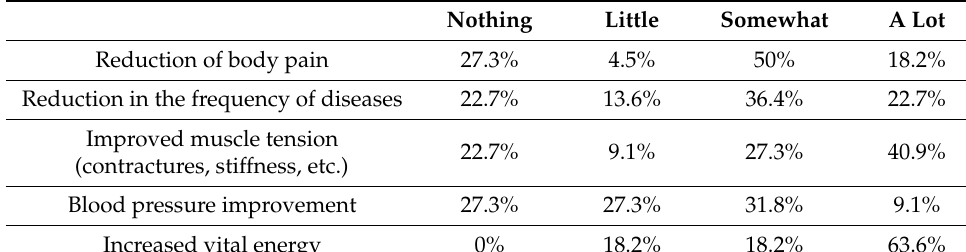
Table 2. Physical health aspects improved by mindfulness practice.